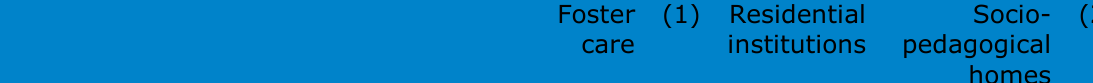
Descriptive statistics on central factors for the sample of children and young people in out-of-home care in Denmark,